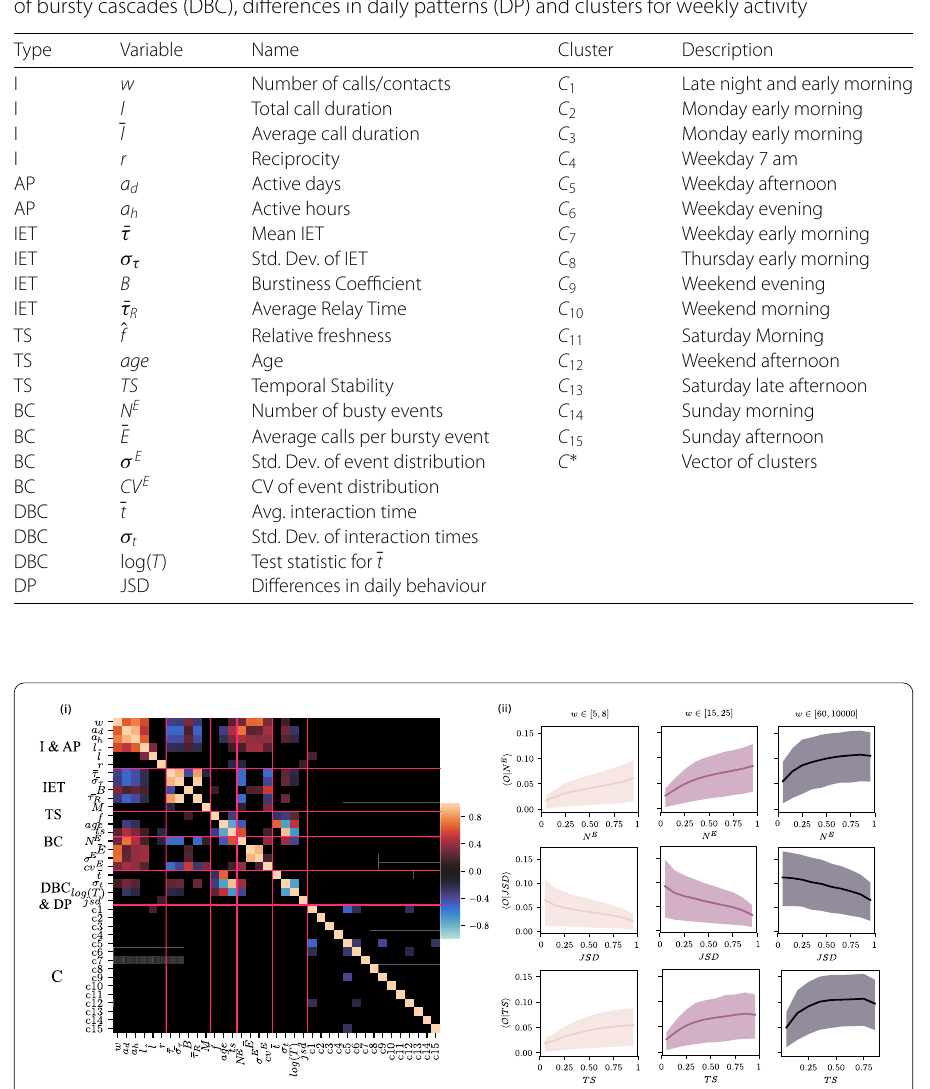
Table 1 Features of human communication used in our analysis. Our feature types - Intensity (I), Active Periods (AP), Inter-event time (IET), Temporal Stability (TS), Bursty Cascades (BC), Distribution of bursty cascades (DBC), differences in daily patterns (DP) and clusters for weekly activity